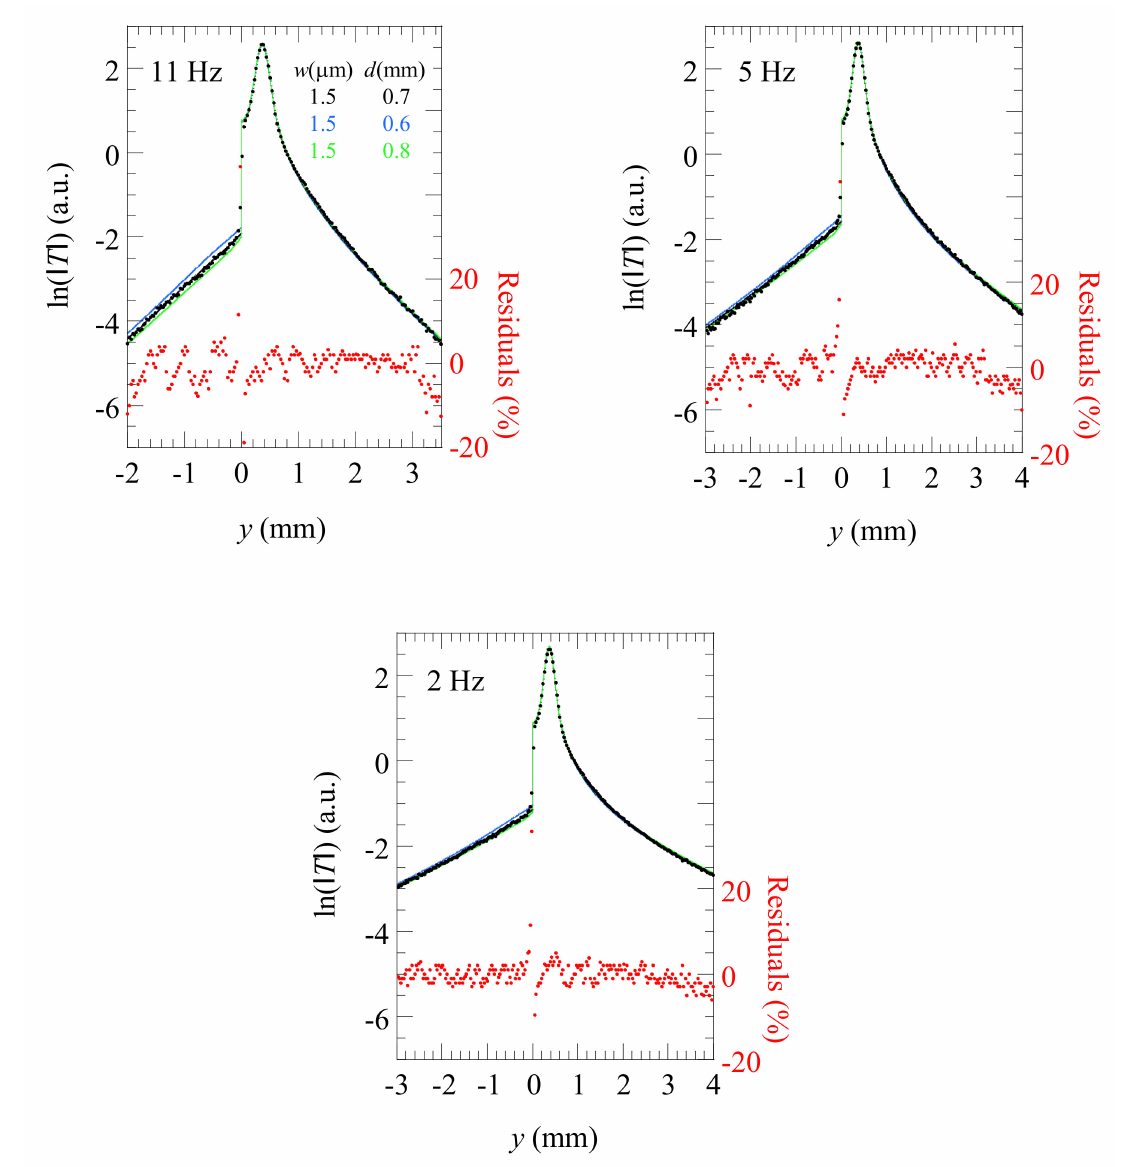
Figure 10. Experimental ln(| T |) profile corresponding to position 1 in Figure 7 for low modulation frequencies. Dots are the experimental results, and the continuous black line is the fitting to the developed FEM model. The vertical scale is kept fixed for a better comparison of the results. Residuals are plotted to visualize the quality of the